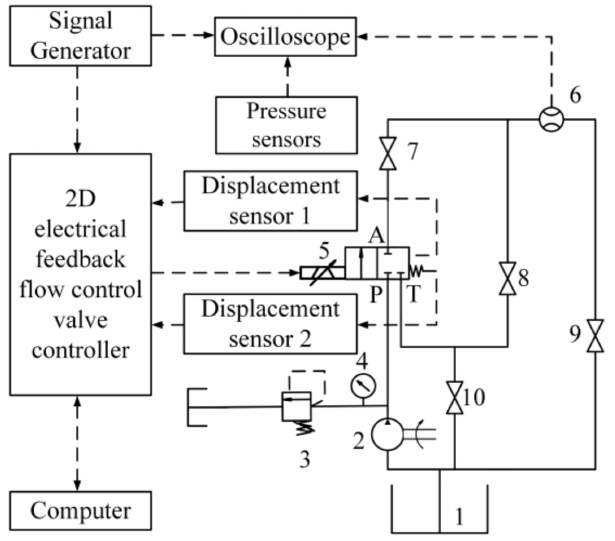
Figure 15. Schematic diagram of the experimental system. 1. oil tank; 2. hydraulic